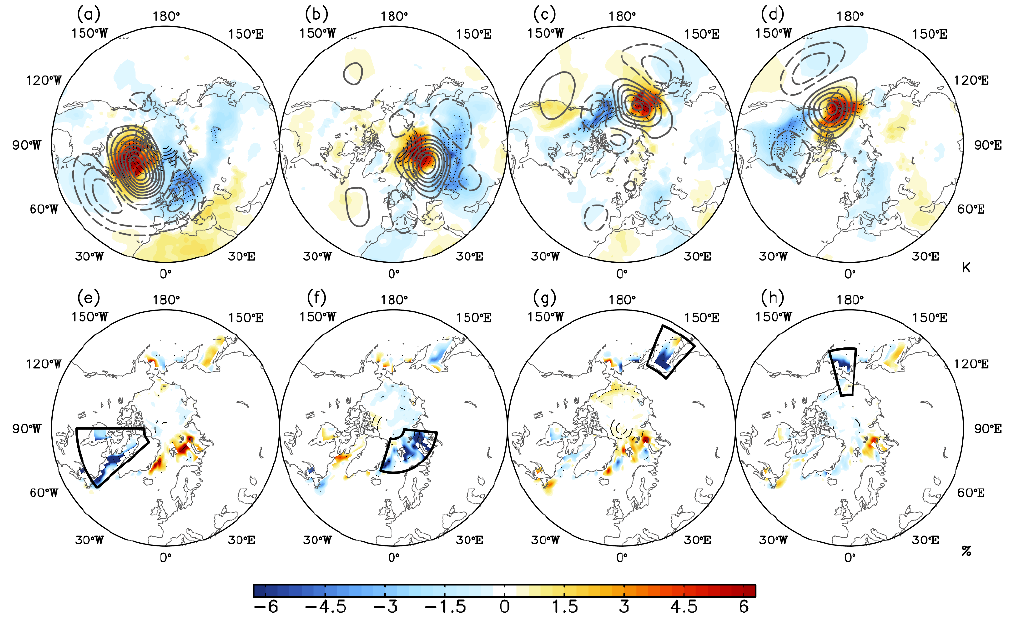
Figure 6. Composite of the blocking events from lag −2 to lag 2 for ( a , e ) GB, ( b , f ) UB, ( c , g ) PB-W and ( d , h ) PB-E. ( a – d ) represent the composites of the 500-hPa geopotential height (contours, unit: gpm) and surface atmosphere temperature (SAT, shading, unit: K) anomaly; ( e – h ) represent the composites of the SIC anomaly distribution. The dotted areas represent values that are above the 95% confidence level based on a two-sided Student’s t test. The lag 0 day represents the peak day (maximum amplitude) during the life cycle of a blocking event.